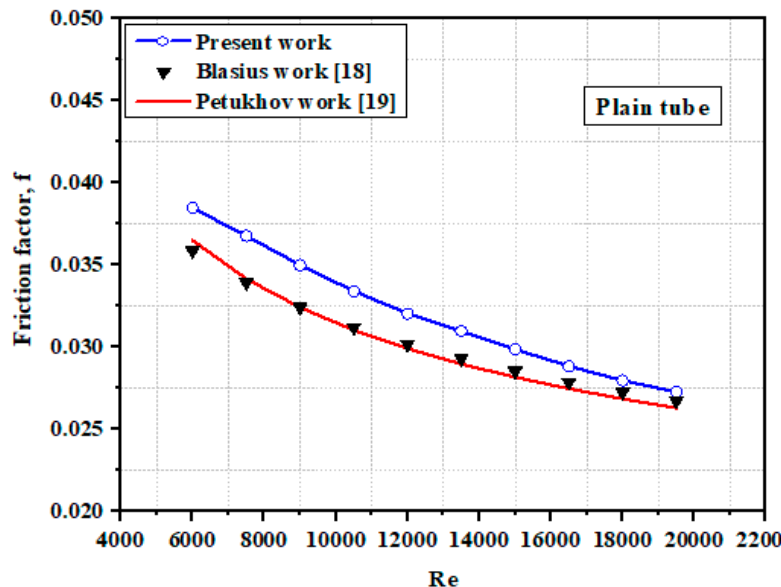
Figure 5. Confirmation of friction factor for plain heat exchanger.